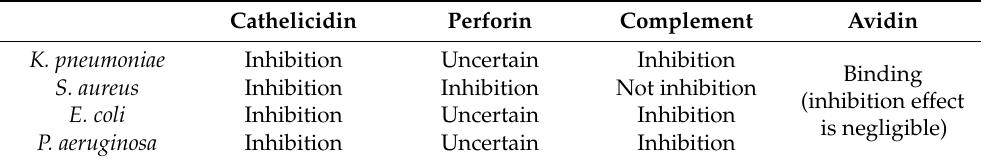
Table 1. Relationship between the proteins and